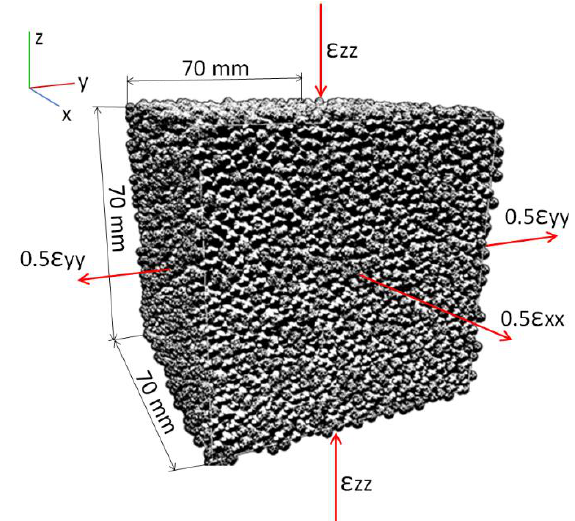
Figure 2. Assembly of particles used to simulate the behavior of the soil samples.